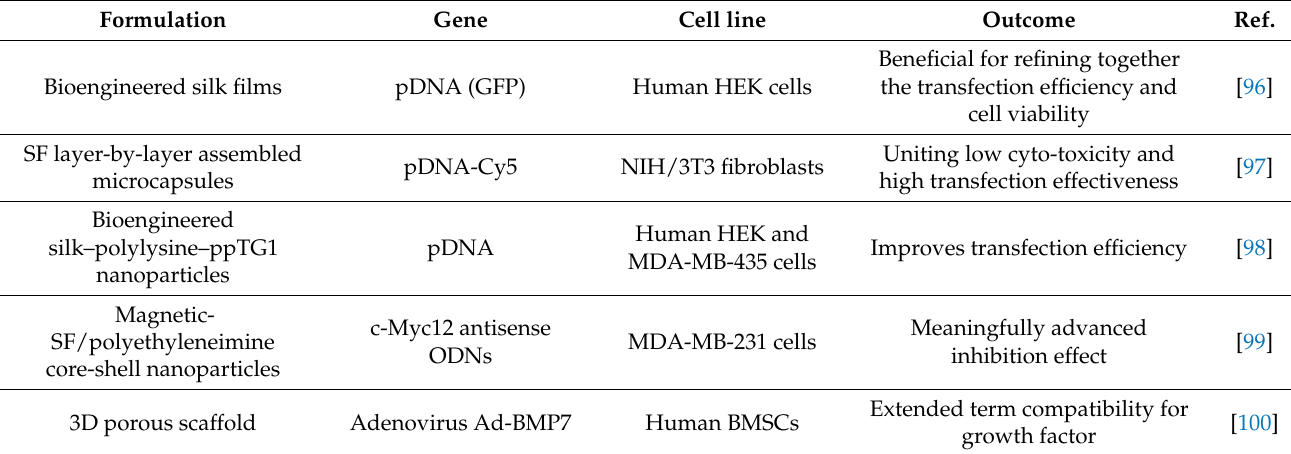
Table 3. SF-based formulations for gene